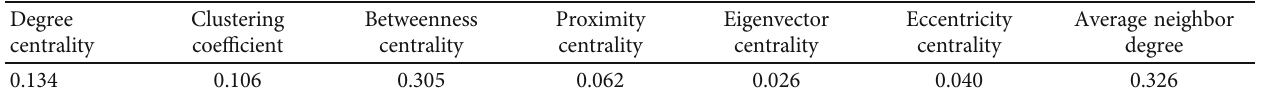
Table 14: The weights of di ff erent indexes in the assembly process of the disc.